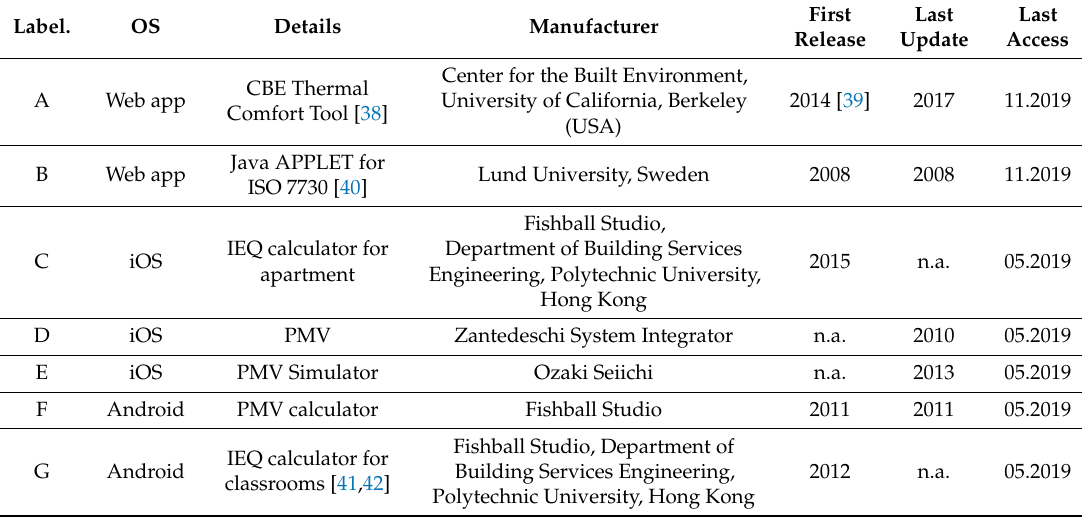
Table 4. Summary of web apps and apps used for the present